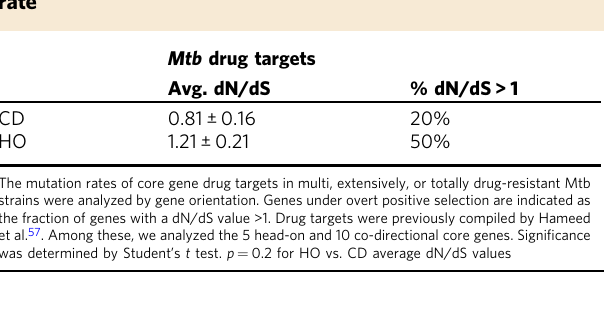
Table 3 HO virulence genes evolve at an accelerated rate